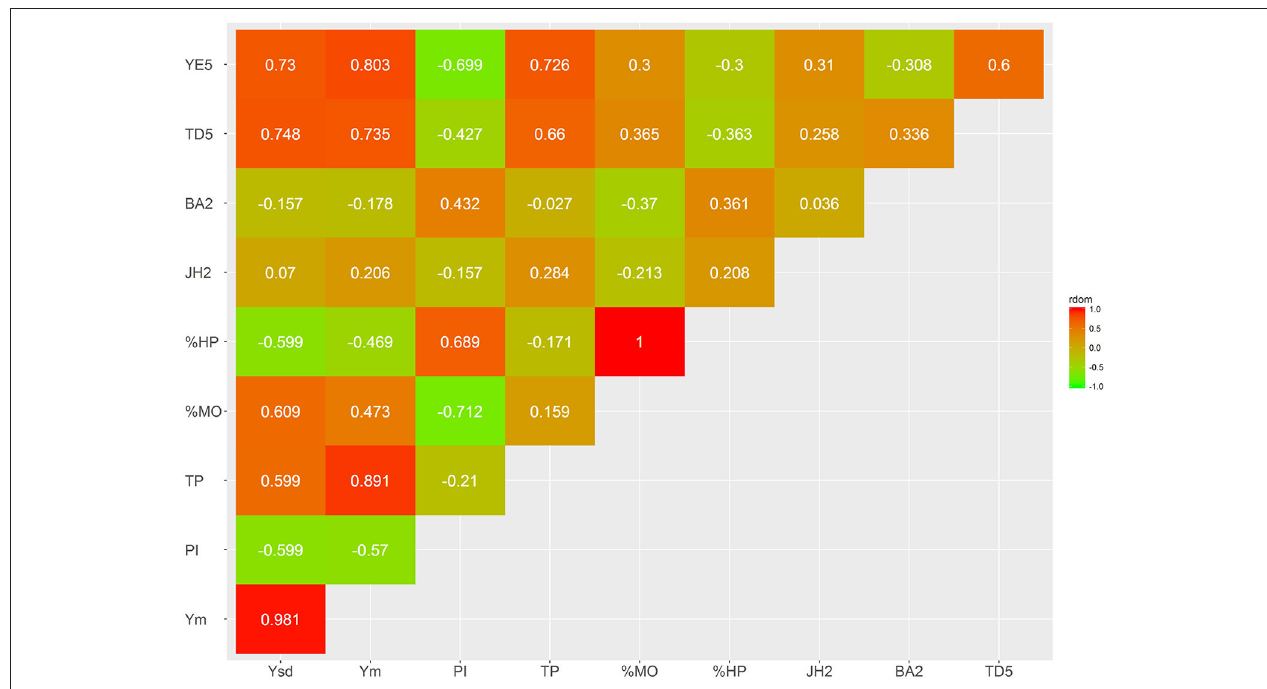
FIGURE 7 | Genetic trait correlations for dominance effects: vigor and disease traits.